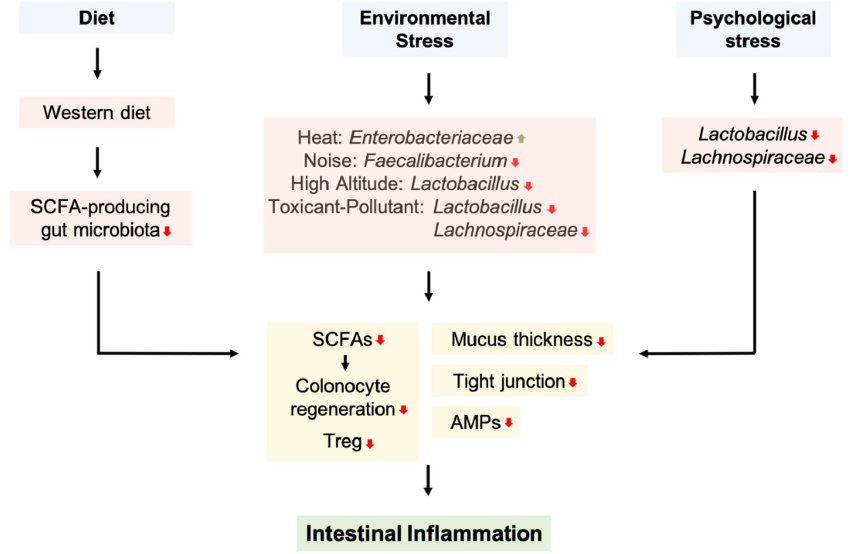
Figure 3. Diet and extrinsic stressors that alter the composition of gut microbiota and are associated with intestinal inflammation A western diet reduced SCFA-producing bacteria. Environmental stressors, including heat, noise, high altitude, toxicants, and pollutants decreased Faecalibacterium , Lactobacillus , and Lachnospiraceae , while increasing Enterobacteriaceae . In addition, psychological stress reduced the proportion of Lactobacillus and Lachnospiraceae . These gut microbiota alterations may decrease mucus, SCFAs, and AMPs production, as well as tight junction protein expression, resulting in intestinal